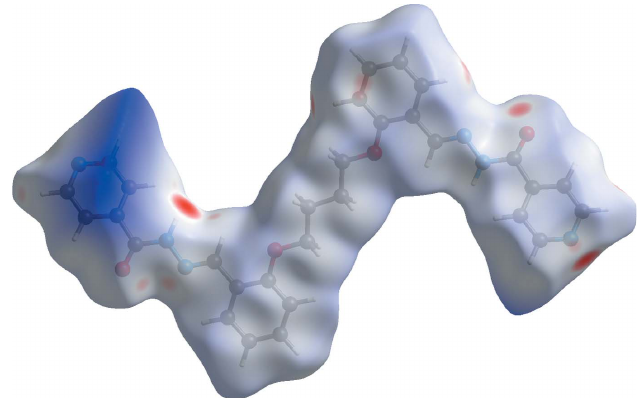
Figure 6 The Hirshfeld surfaces of compound (II), mapped over d norm ; fixed colour scale of (cid:5) 0.490 (red) to 4.945 (blue) arbitrary